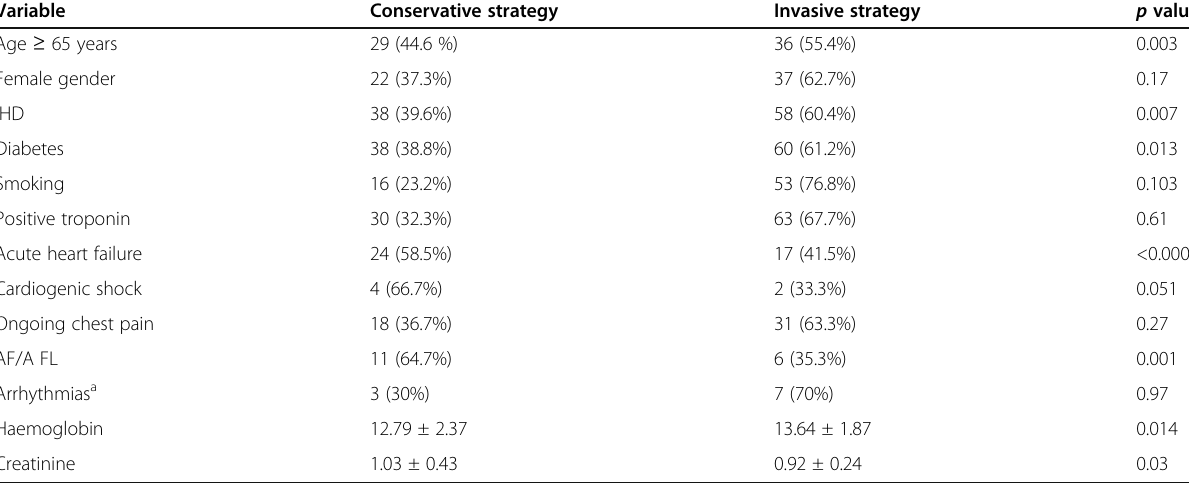
Table 3 Univariate analysis of predictors of invasive strategy in NSTE-ACS Variable Conservative